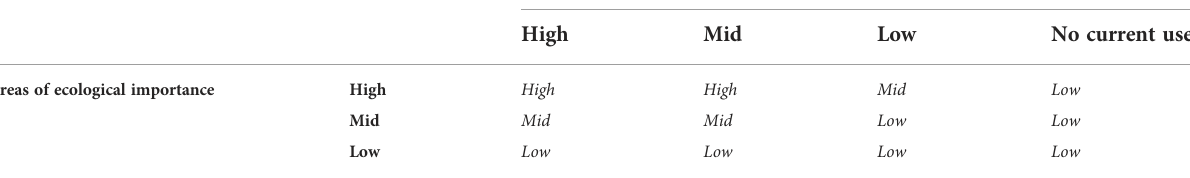
TABLE 2 Rules adopted to determine the ecological risks according to the ecological importance and human